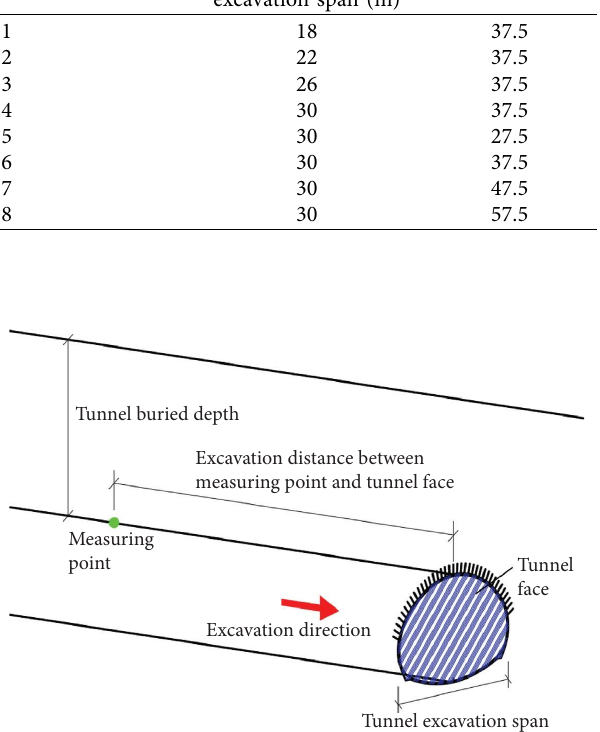
Figure 4: Position relationship between measuring point and various infuencing